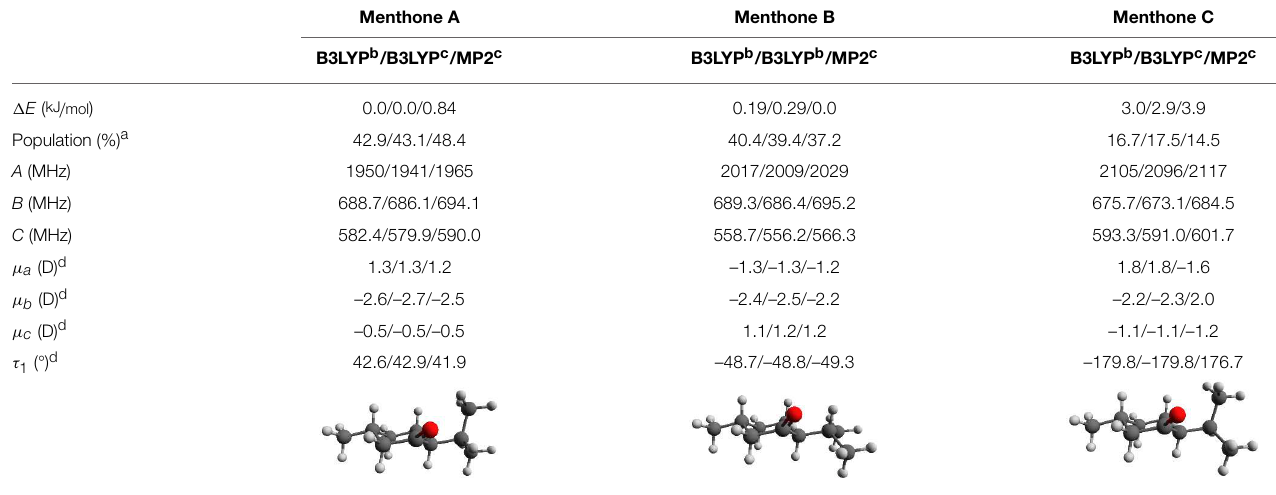
TABLE 4 | Calculated relative zero-point corrected energies, Boltzmann populations, rotational constants, dipole moments, and torsional angles for the three lowest energy conformers of menthone. The results were obtained using three different combinations of theoretical methods and basis sets and they are stated in this order: B3LYP/aug-cc-pVTZ / B3LYP/6-311 ++ G(d,p) / MP2/6-311 ++ G(d,p). Menthone A Menthone B Menthone